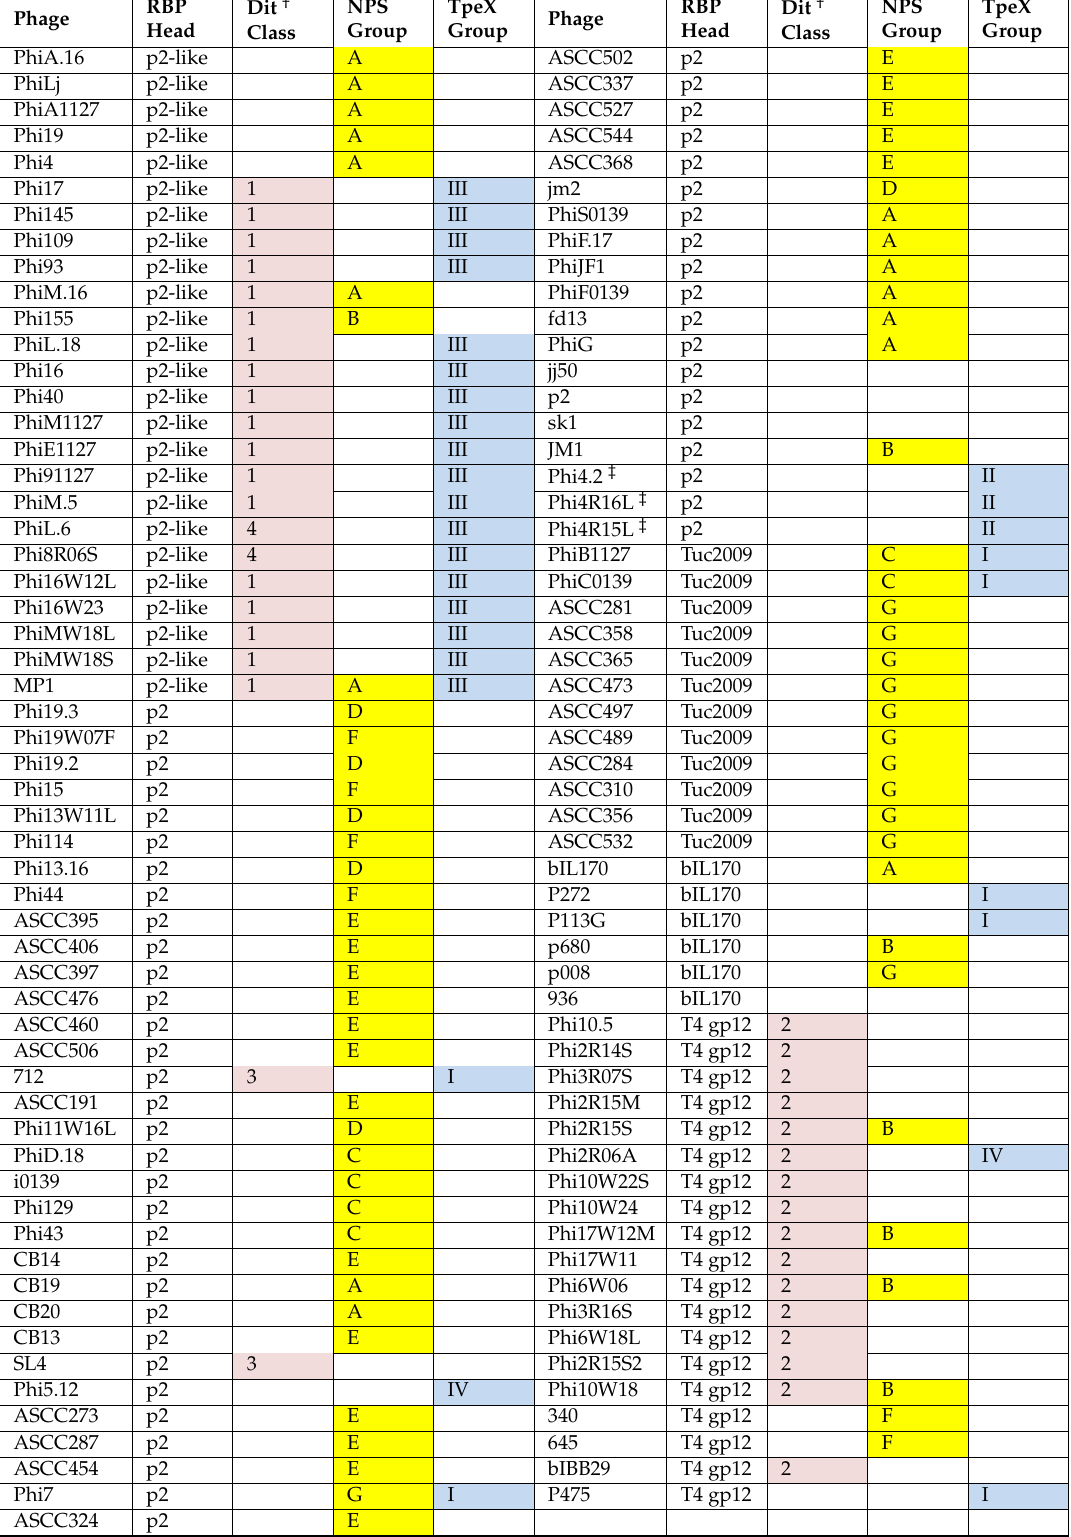
Table 1. List of the 113 phages from the 936 under scrutiny, along with the types of ancillary CBM domains observed in